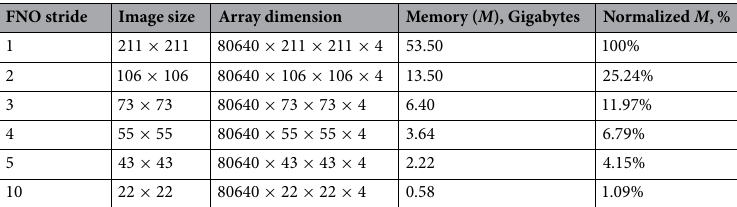
Table 1. Sensitivity of stride with memory consumed by the feature array.